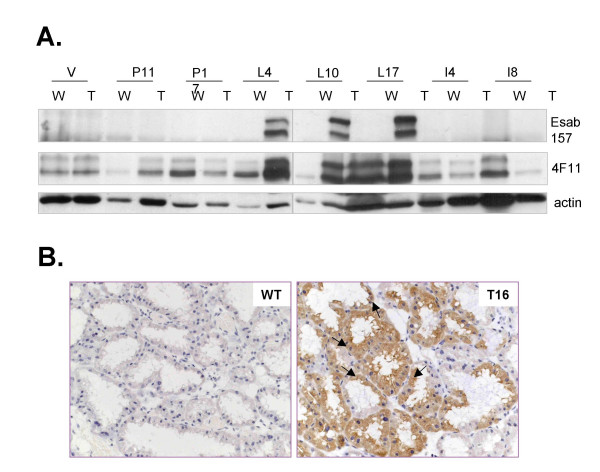
Normal mammary gland development in cortactin transgene mice. (A) Expression of endogenous and transgenic cortactin in mouse mammary epithelium at different stages of mammary gland development as determined by Western blot analysis. Total protein was loaded from the abdominal mammary gland of non-transgenic (W) and transgenic mouse line 16 (T) of virgin female mice (V), mice at day 11 and 17 of pregnancy (P11, P17), day 4, 10 and 17 of lactation (L4, L10, L17) and day 4 and 8 of involution (I4, I8). Monoclonal antibody Esab157 was used to recognize specific human transgene expression, whereas monoclonal antibody 4F11 recognizes both human and mouse cortactin. Actin was used as a loading control. (B) Immunohistochemical detection of cortactin transgene in a 10-days lactating mammary gland (L10). WT, wild type; T16, transgenic mouse line 16. About 50% of epithelial cells from the transgenic section stained positive for cortactin. Arrows indicate cortactin localization at cell-cell contacts. Sections were counterstained with haematoxylin.